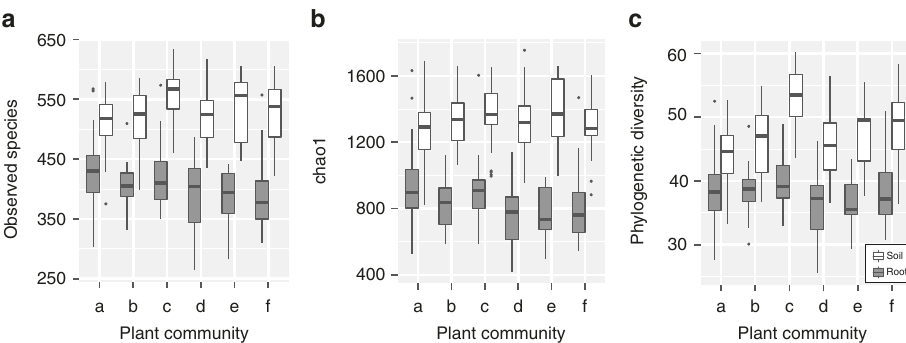
Fig. 4 Alpha diversity metrics of Cooloola root and bulk soil microbial communities across the six sampling sites. See Fig. 1 for number of samples in each group. Box and whisker plots showing a observed species richness, b estimated species richness (chao1), and c Faith ’ s phylogenetic diversity. White rectangles represent bulk soil communities and grey rectangles represent root communities. The centre line within rectangles represents the median values, and the two ends of the rectangles represent upper and lower quartiles. The upper whisker extends to the highest value within 1.5× the interquartile range above the upper quartile, whereas the lower whisker extends to the lowest value within 1.5× the interquartile range below the lower quartile. Values outside this range are represented by black dots . Total number of root samples is 183 and soil samples is Table 2 Cooloola core root microbiome taxa summarized by genus classi fi cation Taxonomy